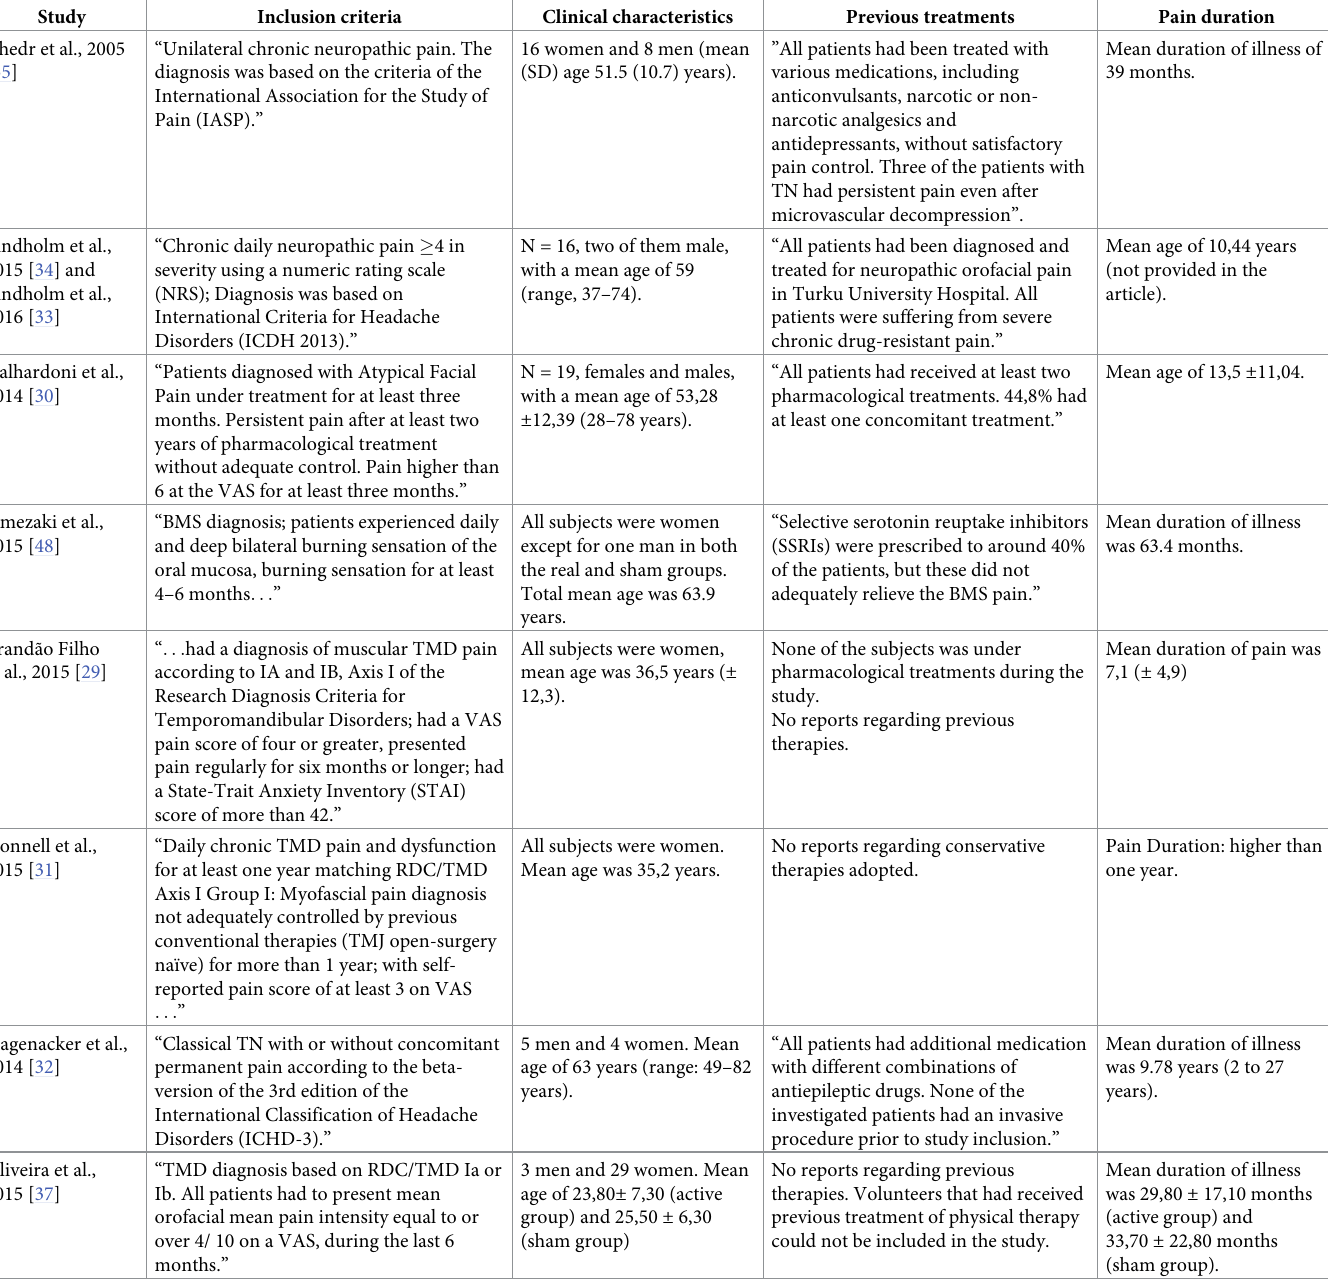
Table 2. Main characteristics of the sample in each included